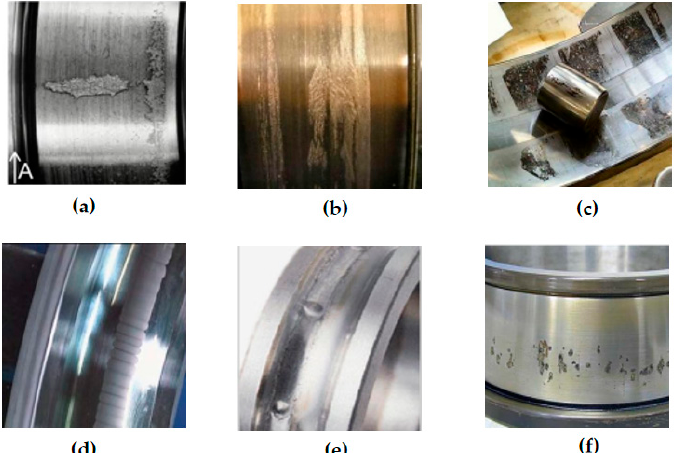
Figure 4. Forms of frictional failure of wind turbine bearings, ( a ) Bearing fatigue failure resulting in surface rolling contact fatigue; ( b ) Adhesive wear in bearing wear types; ( c ) Bearing corrosion resulting in moisture corrosion; ( d ) Bearing galvanic corrosion due to excessive current; ( e ) Plastic warpage of the bearing due to excessive load; ( f ) Bearing surface fracture cracks (Adapted with permission from Refs. [63–67]. Copyright 2016 Elsevier).